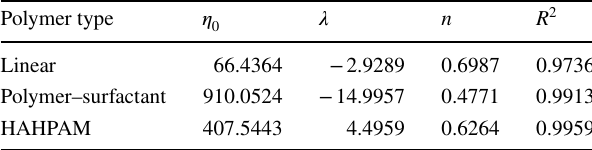
Table 2 Carreau model data analysis for three polymer solutions (2000 mg L −1 ) Polymer type